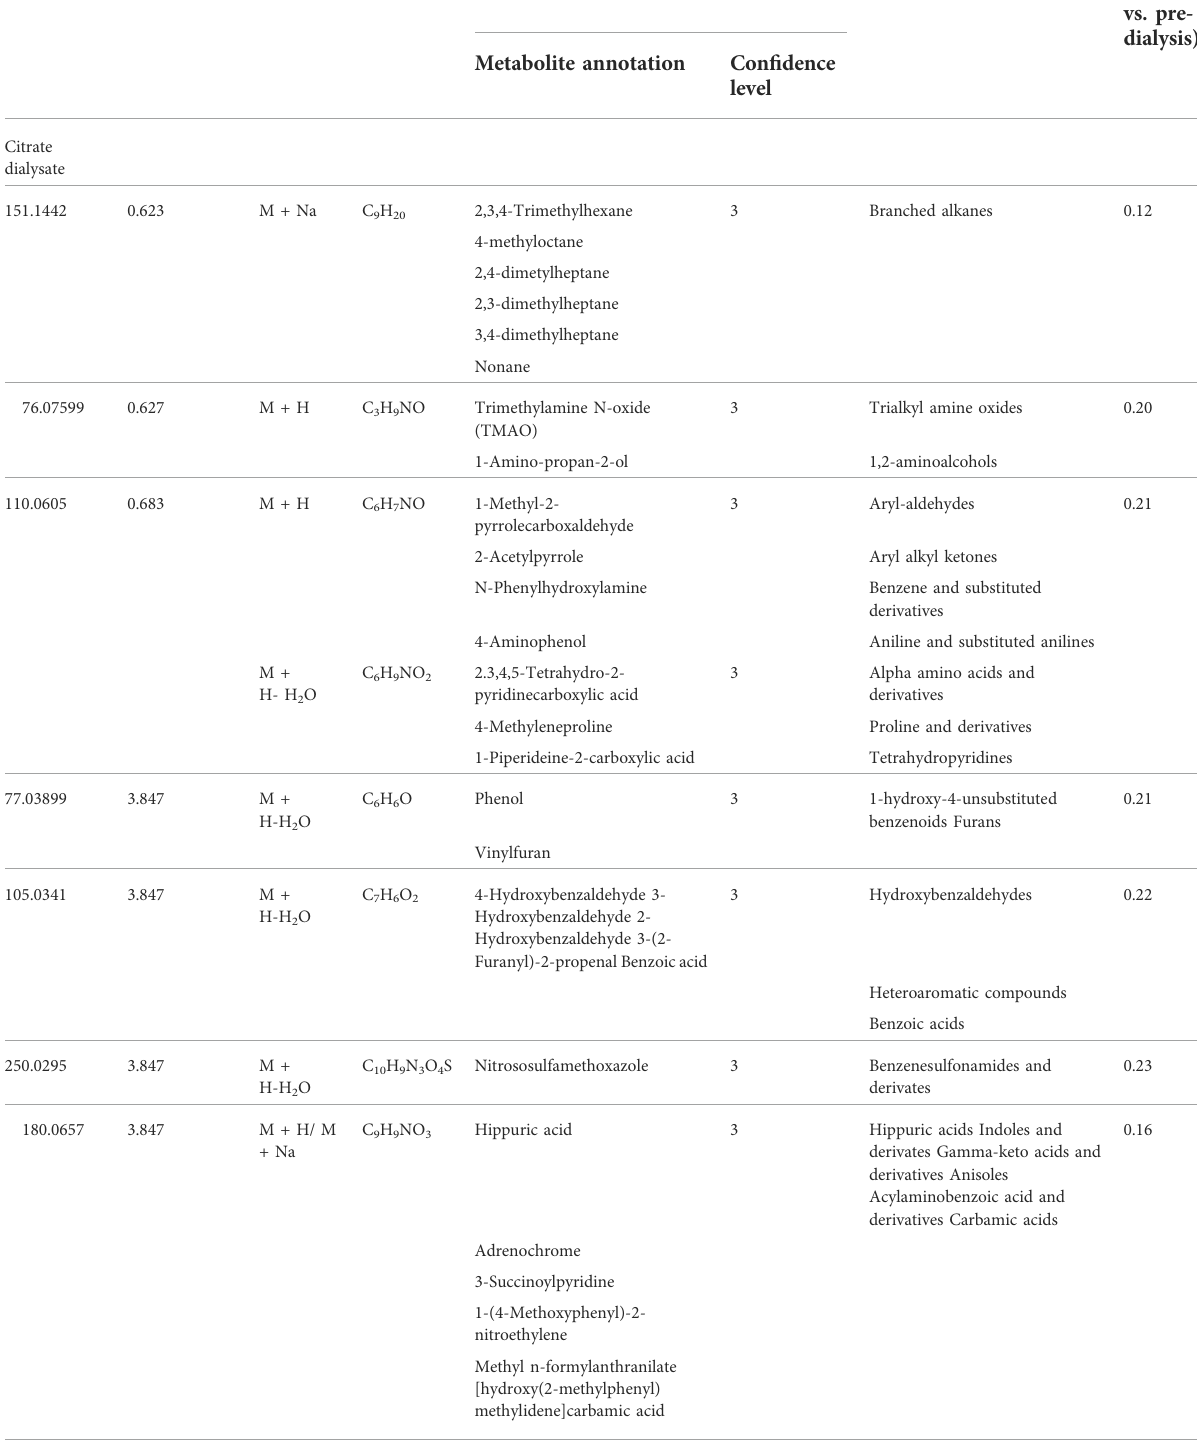
TABLE 4 Identi fi cation of the most discriminant metabolomic variables between pre- and post-dialysis with differences between dialysates. Accurate